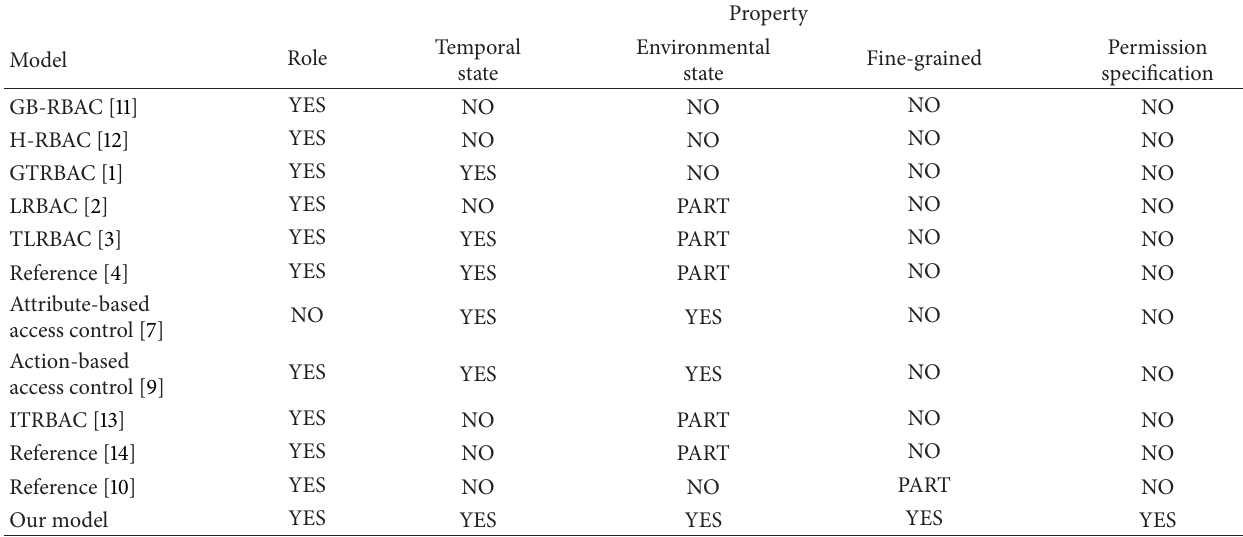
Table 1: Comparison between our model and current